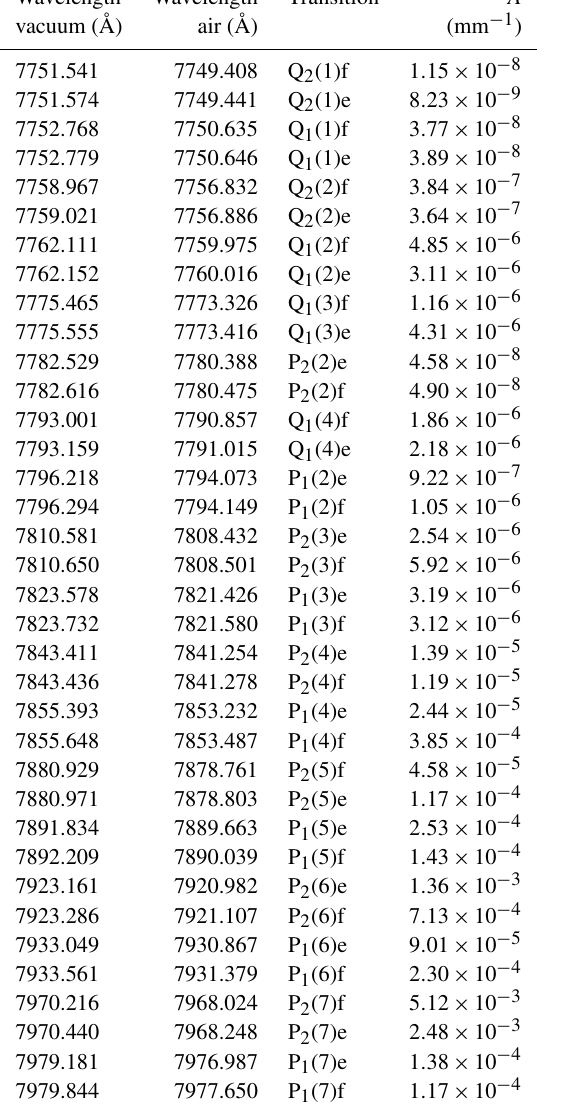
Table 3. Water vapour transmission at wavelengths of OH(9–4) lines. Vacuum wavelengths are from Rousselot et al. (2000), with conversion to air wavelengths undertaken as specified by Ciddor (1996). At each wavelength, water vapour transmission is given by a function of PWV: T λ = exp ( − A × PWV ) , with PWV in mm. Wavelength Wavelength Transition A